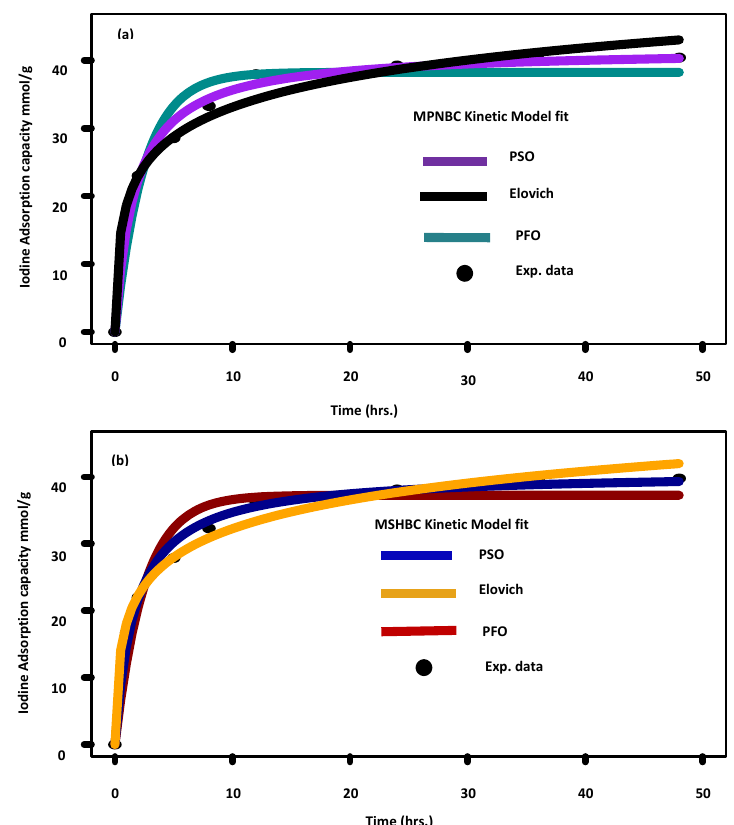
Fig. 2 : The effect of contact time on the adsorption of Iodine solution onto the bark biochar, (a) Mushuma, (b) Mupani, fitting three Models (Pseudo first order, second-order, and Elovich) after 48 hr. of agitation